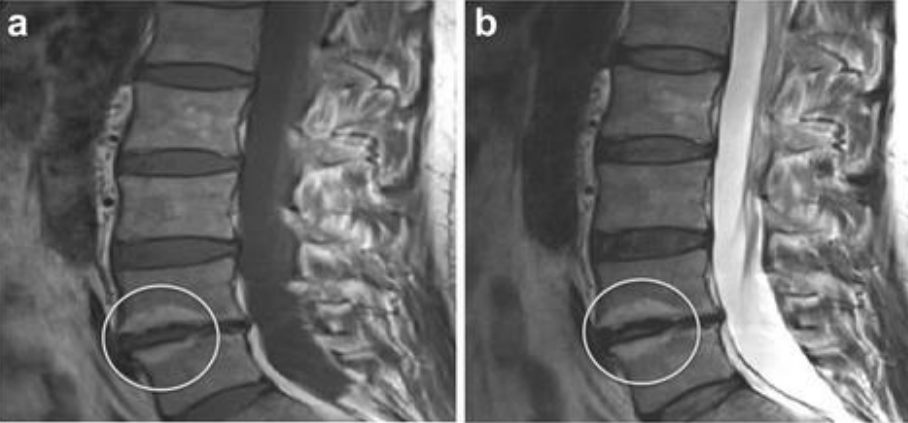
Figure 2. Modic type II change (reused from [36]). ( a ) T1-weighted image; ( b ) T2-weighted image. The white circle showing Modic type II change.